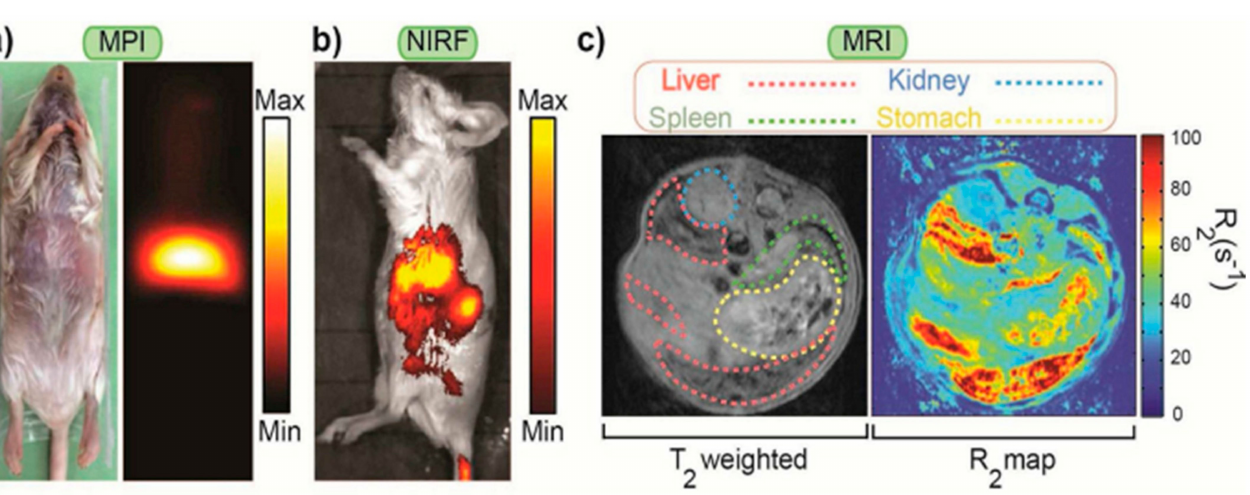
Figure 3. Complementary imaging modalities ( a ) colorized magnetic particle imaging (MPI) ( b ) near-infrared fluorescence (NIRF) and ( c ) MRI T 2 weighted and colorized R 2 images 72 h after injection of nanoparticles (NPs) functionalized with NH 2 -PEG-FMOC (100 µ L, 1 mg Fe/mL). Reprinted with permission from ref. [26]. Copyright 2015